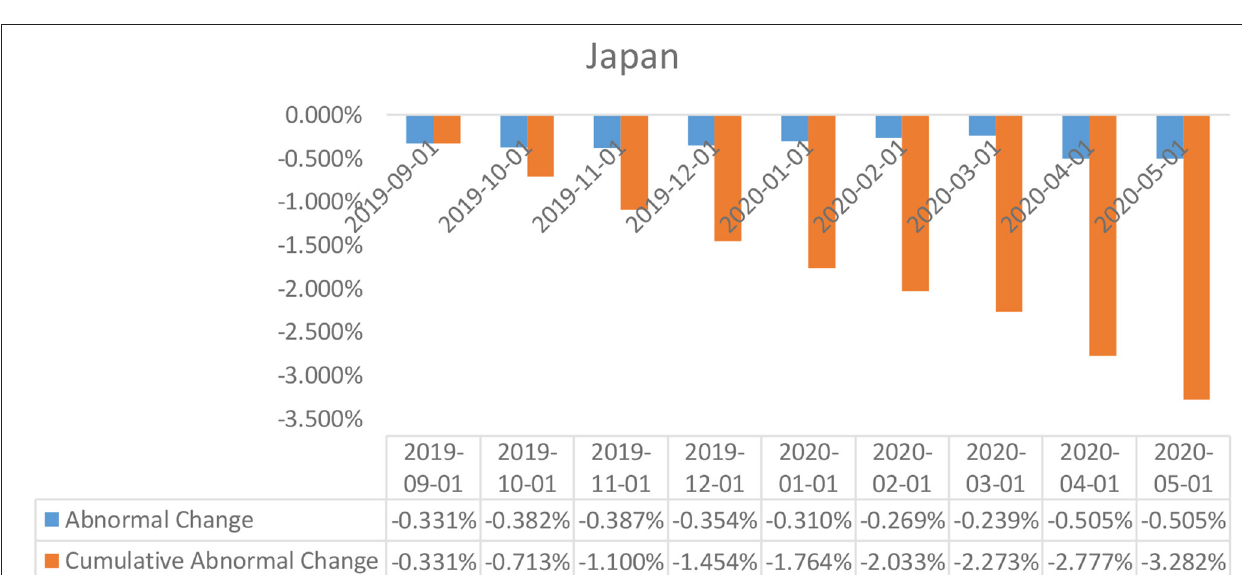
FIGURE 3 | Abnormal changes in policy interest rates over the event window: